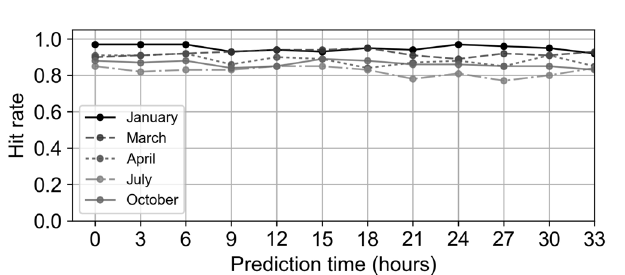
Figure 5. Hit rates of the estimated directions using the forecast winds obtained from JMA. The five-year average hit rates of the estimated directions are shown using the winds forecast from 3 to 33 hours in advance in January, March, April, July, and October. The hit rates at 0 hours indicate the directions estimated using the assimilated winds. The graphs are created using Python